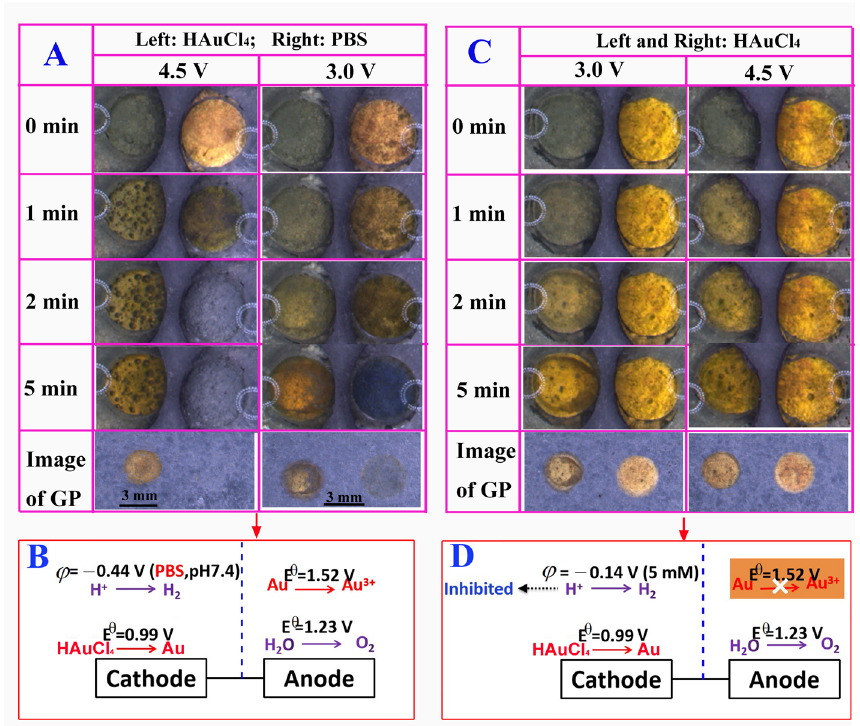
Figure 2. Deposition of Au particles on GP in the left reservoir. GP in the right reservoir was pre-modified with Au particles under 4.5 V for 300 s through bipolar deposition. ( A ) The left reservoir was filled with 5 mM HAuCl 4, and the right reservoir was filled with 10 mM PBS. ( B ) Redox reactions occurred at the two poles of the BPE in ( A ). ( C ) Both reservoirs were filled with 5 mM HAuCl 4 . ( D ) Redox reactions occurred at the two poles of the BPE in ( C ). The deposition time was 300 s.